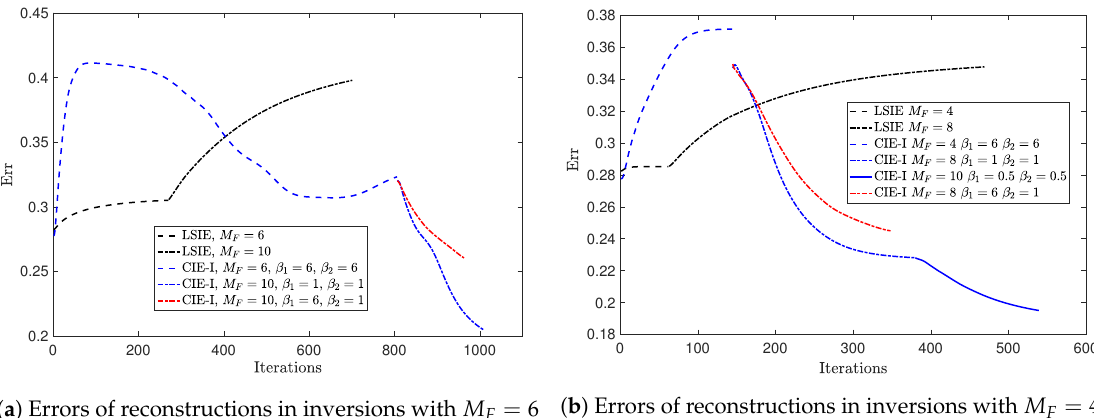
( a ) Errors of reconstructions in inversions with M F = 6 and 10. Figure 13. Errors of reconstructions obtained by different inversion methods for Example 3